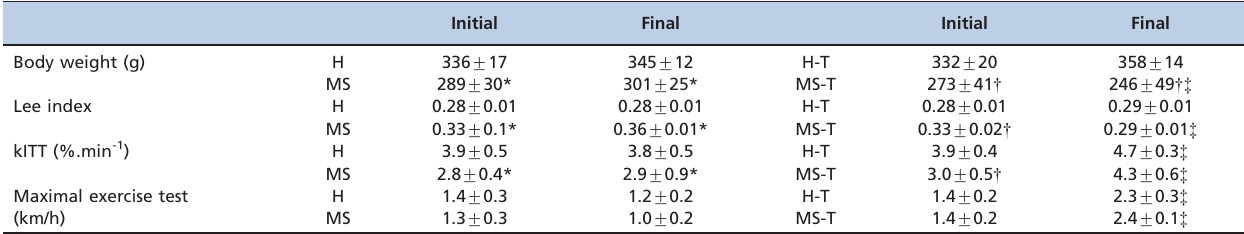
Table 1 - Effect of exercise training on the studied